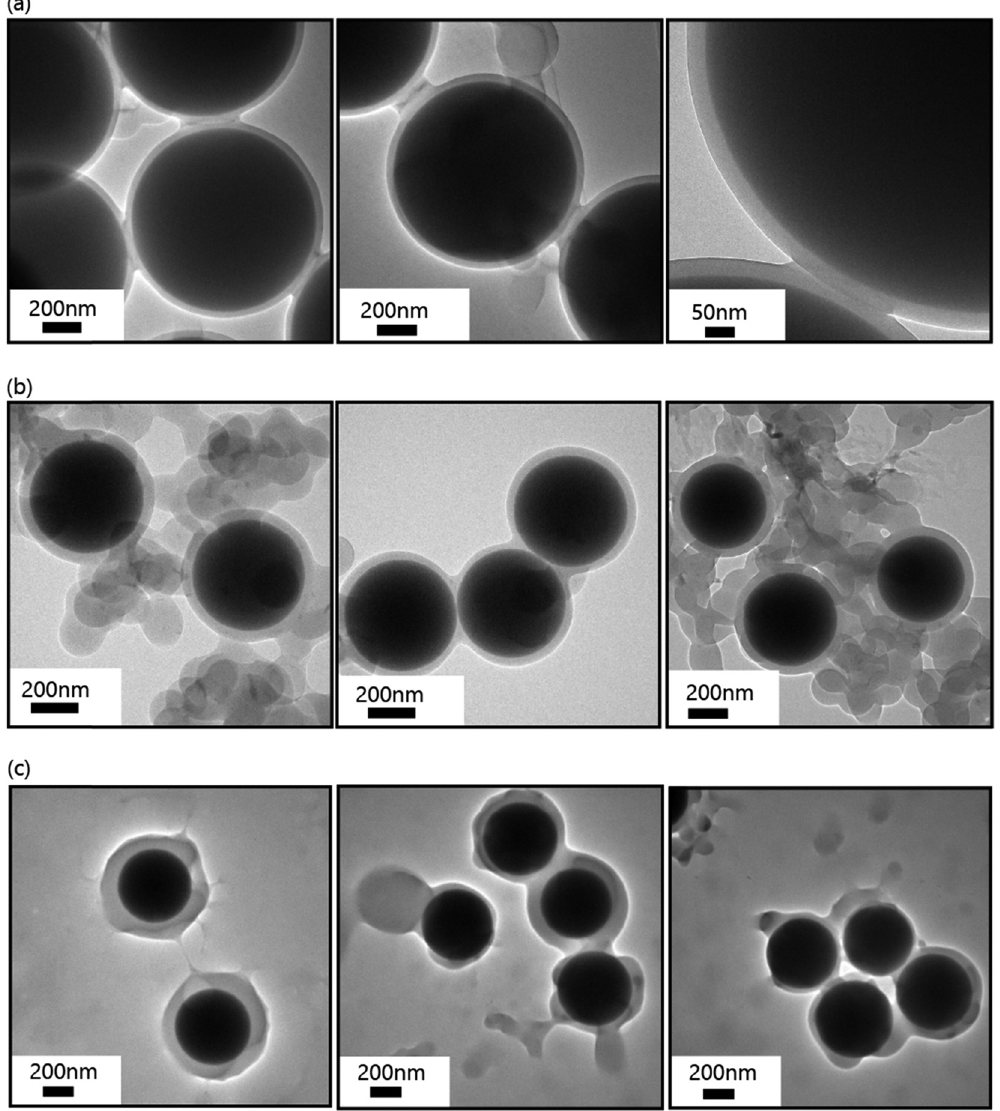
Figure 1: TEM images of the PMMA/SiO 2 – MAPTMS core – shell particles prepared under three conditions: PMMA ( a ) , PMMA ( b ) , and PMMA ( c ) , as shown in Table